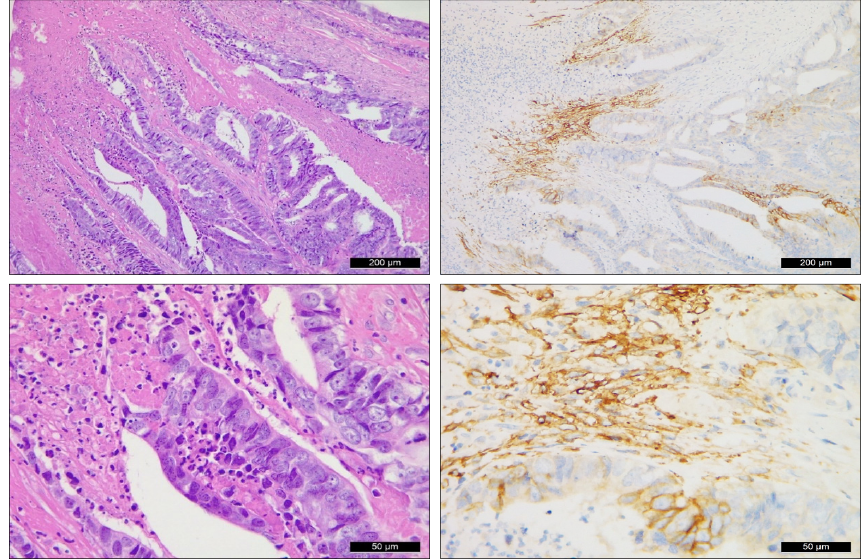
Figure 3. CAIX expression in epithelial and mesenchymal cells of the neostroma in rectal carcinoma ( upper row 10 × , lower row 40 ×